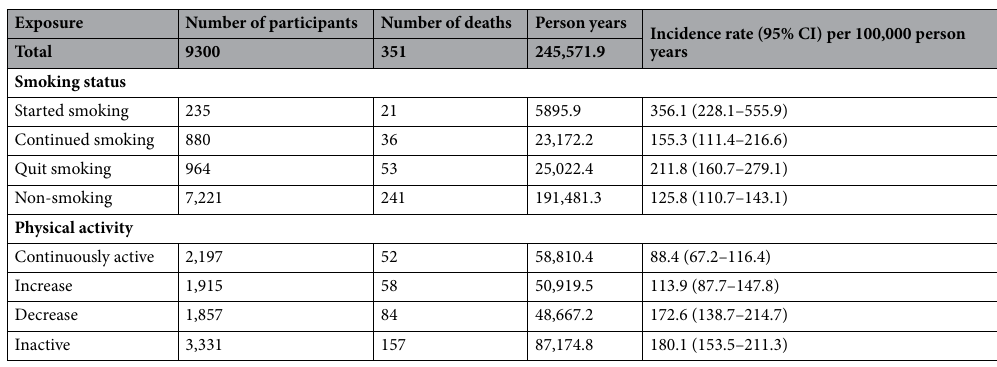
Table 1. Incidence rates of all-cause mortality in the cancer survivors’